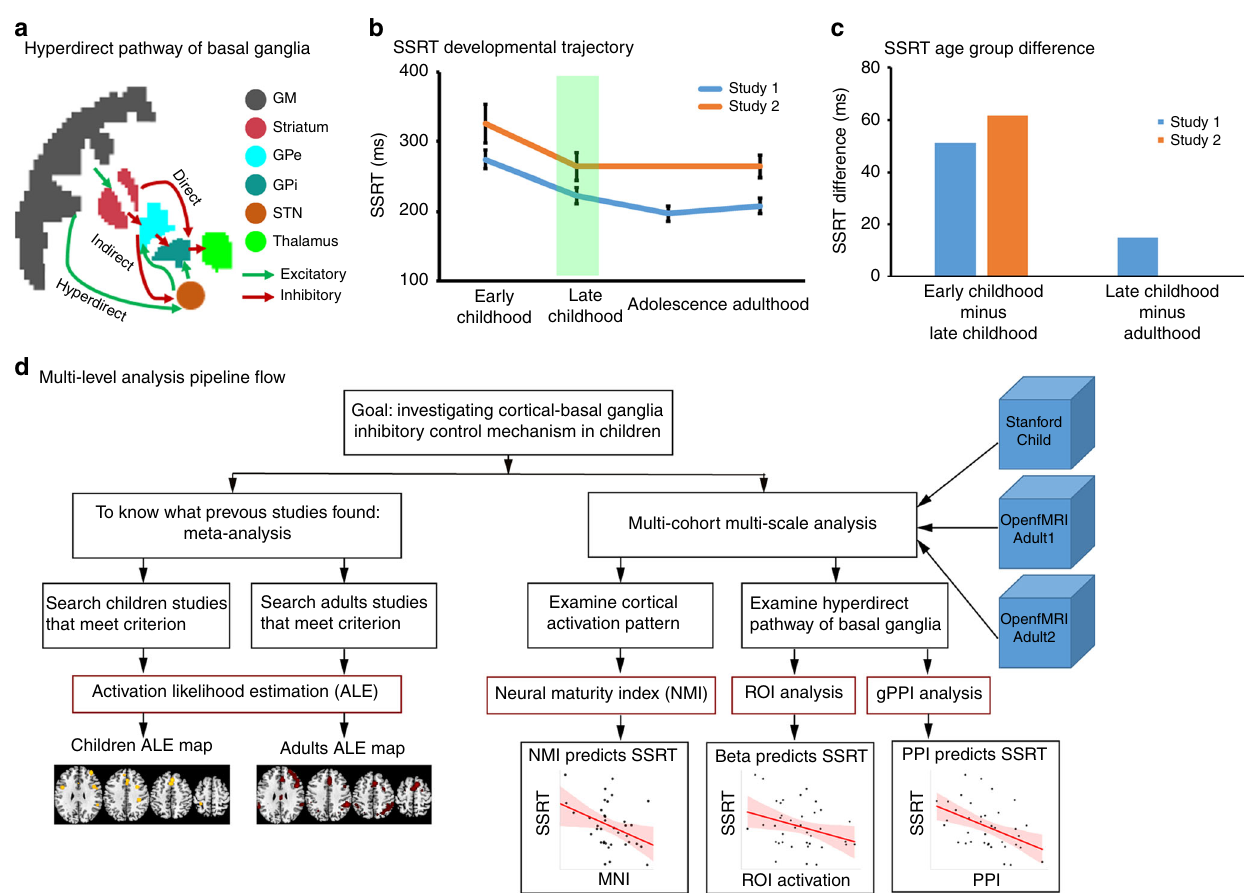
Fig. 1 Behavior, cortico-basal ganglia pathways and pipeline. a Illustration of three cortico-basal ganglia pathways, including the hyperdirect